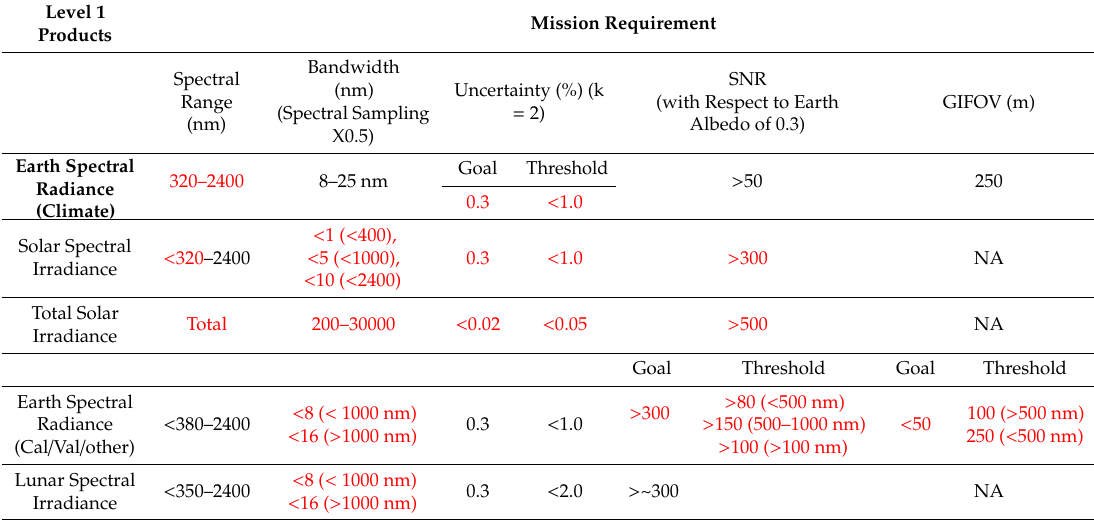
Table2. Missionperformancerequirements(climateandcalibration)redindicatesadrivingrequirement. Signal to noise ratio (SNR) values are given with respect to an average Earth albedo of 0.3 and for the corresponding ground instantaneous field of view